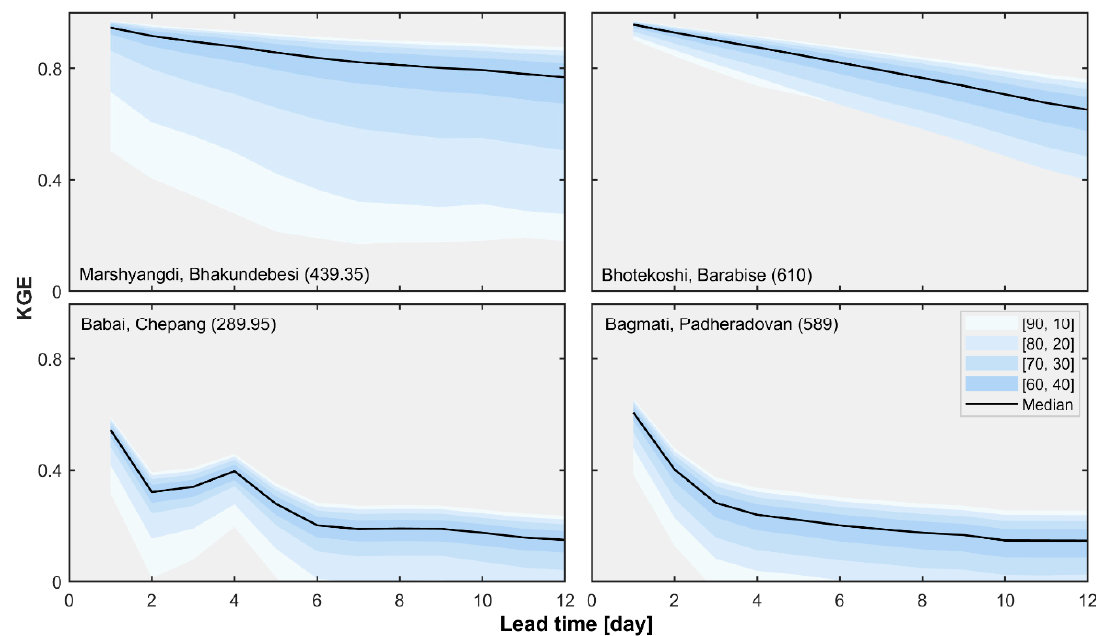
Figure 8. Percentile plots showing the evolution of Kling–Gupta efficiency (KGE) with lead time for four river basins described in Figure 7. Each percentile refers to the KGE computed for streamflow forecasts exceeding corresponding percentile flow. For example, 90th percentile KGE represents the KGE computed for streamflow forecasts >90th percentile flow. The envelope corresponds to each 10th quantile on either side of the median flow. The higher and lower flow quantiles shown in the interval correspond to the lower and upper bounds of the envelope, respectively. For example, the interval [90, 10] corresponds to the KGE computed for 90th and 10th percentile flows, respectively.